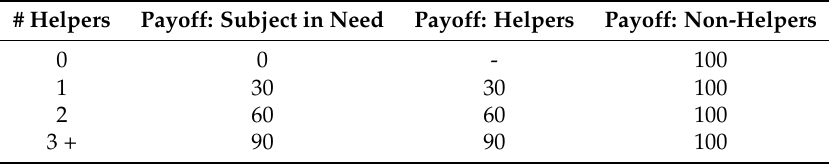
Table 1. Helping game